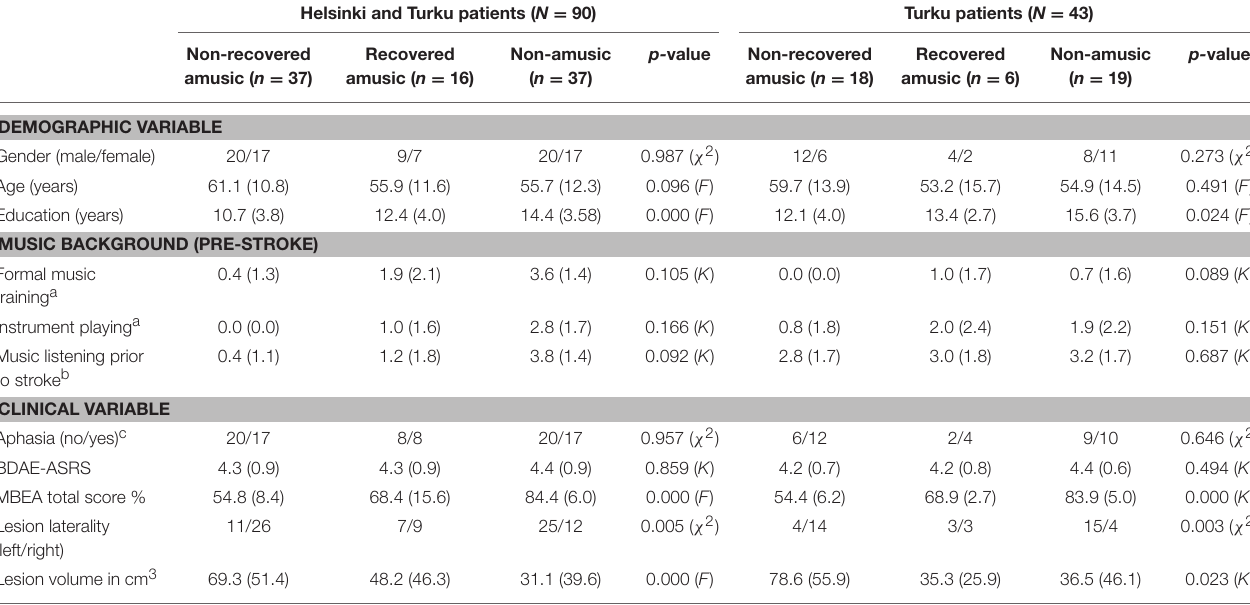
TABLE 1 | Demographic and clinical characteristics of the